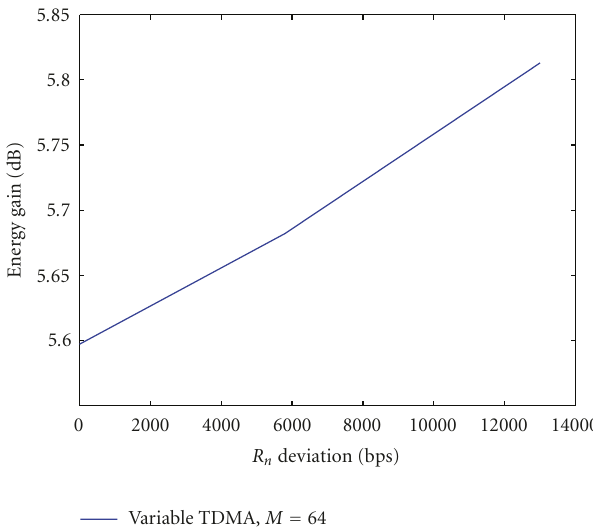
Figure 4: Energy gain with respect to variable length TDMA with 64-QAM modulation, N = 896 symbol periods.